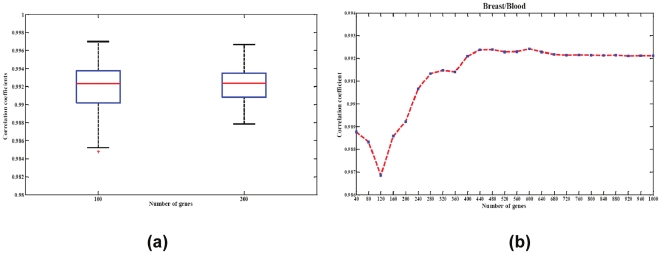
Robustness of the signature matrix.(a) Boxplot displaying robustness of chosen signature matrix to gene content. The correlation coefficient distribution (Y axis) is depicted for signatures composed of 100 or 200 randomly selected differentially expressed probesets. (b) Deconvolution performance across a range of signature sizes. The experiment is conducted by increasing the number of cell-type-specific gene probes step-wisely from 40 to 1000.